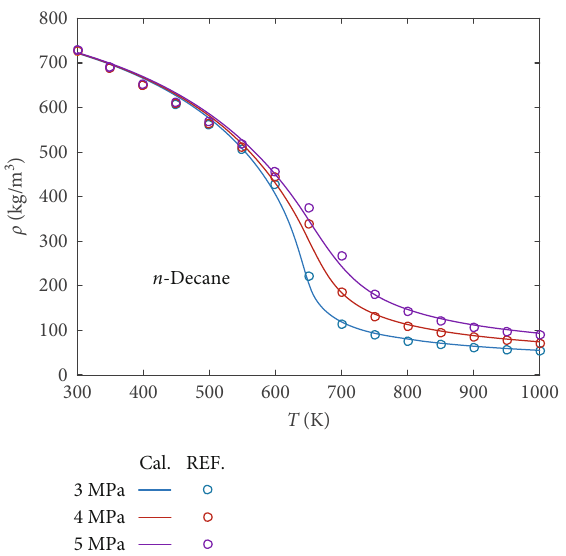
Figure 1: Comparison of densities of n -decane under di ff erent pressures.